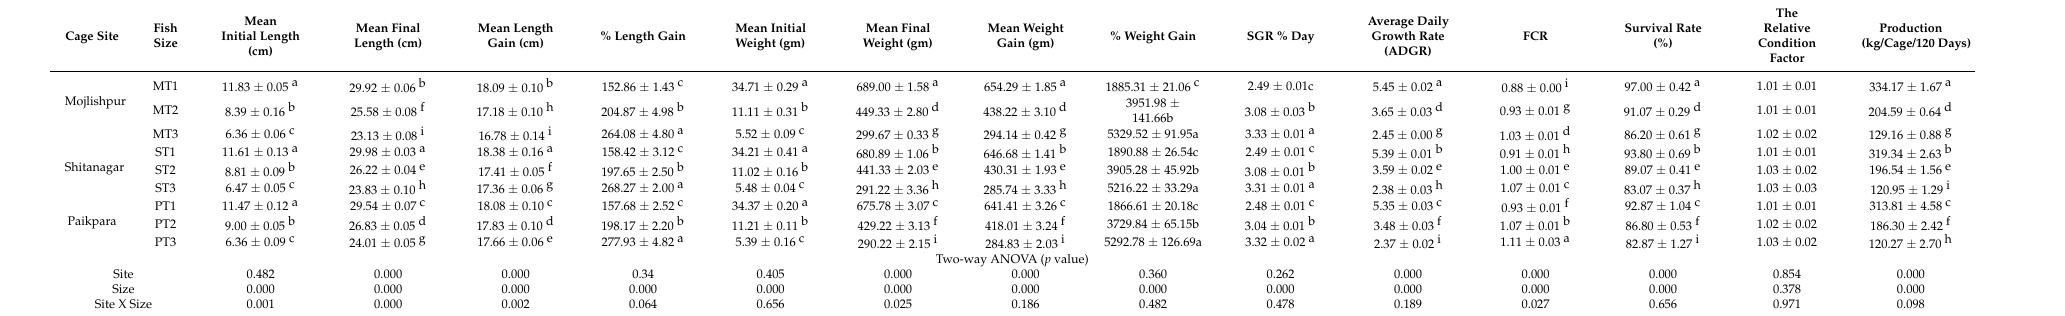
Table 3. Growth parameters of Nile Tilapia ( O. niloticus L.) under cage-culture system in Titas River of Bangladesh with different stocking densities in the first cycle (March–July).